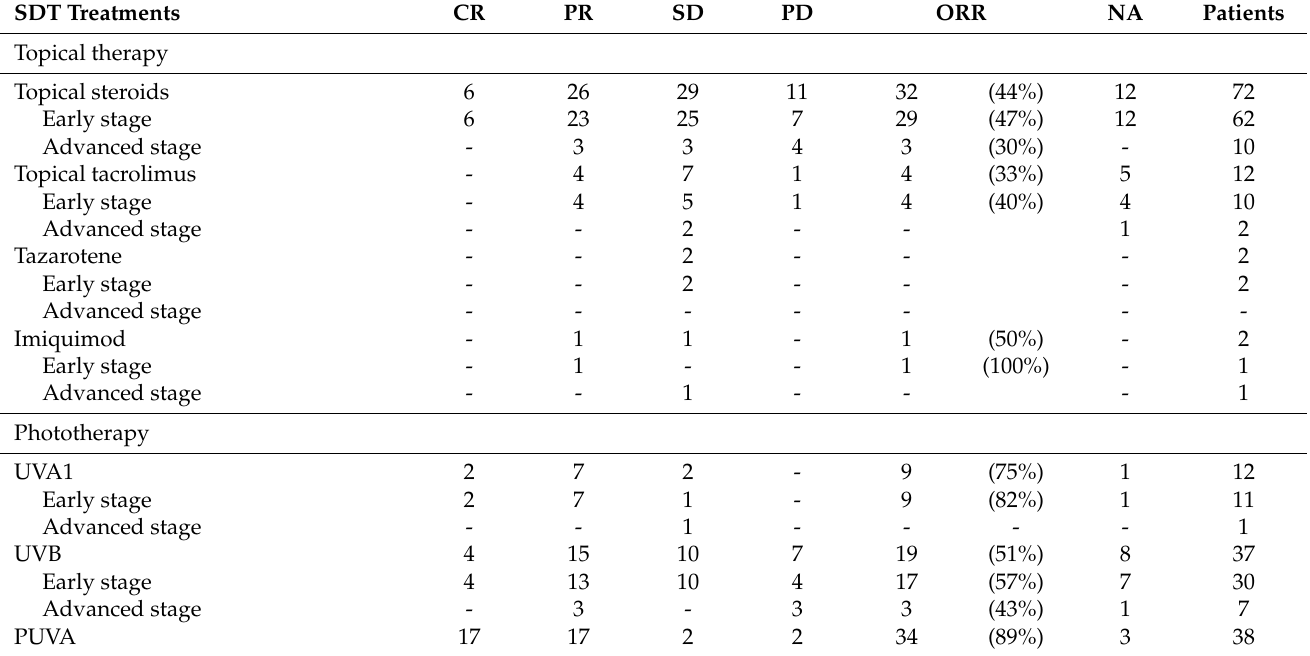
Table 4. Initial treatment outcomes for different skin-directed therapy modalities in patients with early-stage disease and advanced-stage disease at the time of MF